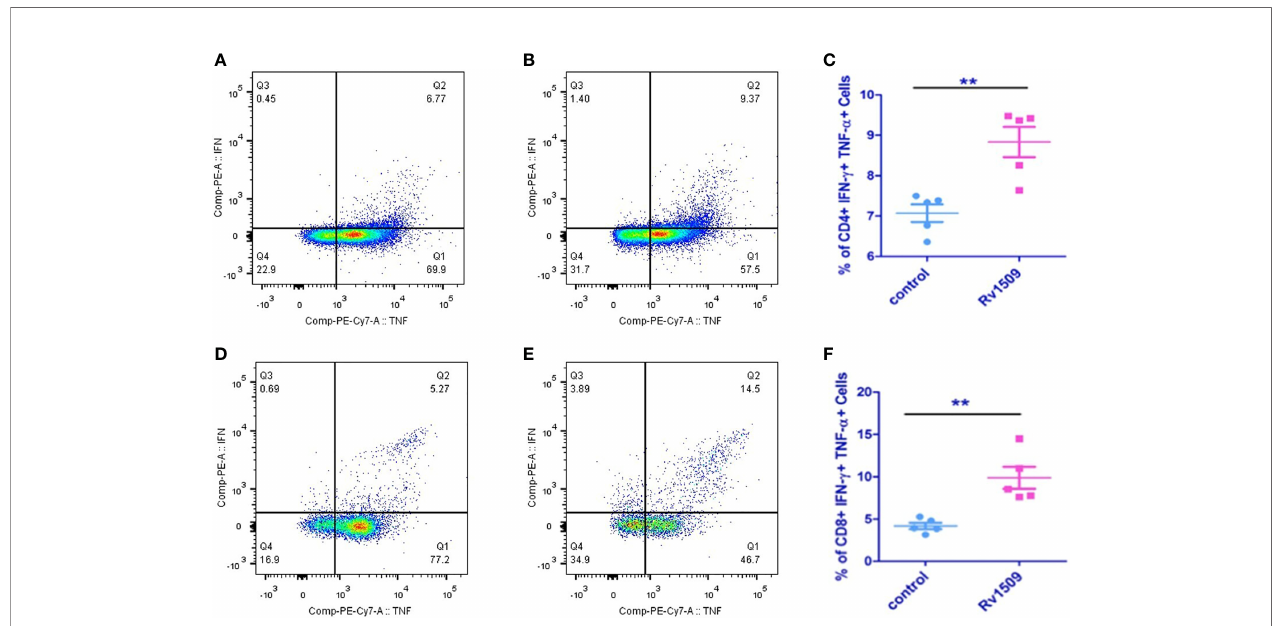
FIGURE 5 | Recombinant Rv1509 protein increases number of poly-functional IFN g and TNF a secreting CD4+ and CD8+ T cells. Splenocytes from immunized and control mice were re-stimulated with polymyxin treated recombinant Rv1509 protein in culture in the presence of Golgi plug/Golgi stop solution for 8 hours. Cells were washed, harvested and labelled for CD4+/CD8+ surface marker and intracellular IFN g and TNF a . FACS analysis was performed by selecting splenocyte population followed by gating for CD3 initially. Selected population was then double gated to reveal CD4+ and CD8+ population. The CD4+ and CD8+ populations were then individually gated for IFN g and TNF a . The Dot plots represent the percentage population of polyfunctional T cells (IFN g +TNF a positive cells) from a single experiment, representative of total of two experiments. (A, B) Representative FACS plot of control and Rv1509 protein treated cells. (C) Rv1509 treatment increases the number of CD4+ cells double positive for IFN g and TNF a . (D – F) FACS plots and graph represent the CD8+ T cells in control and Rv1509 immunized animals after in vitro stimulation with protein. Rv1509 protein treatment results in an increase in number of CD8+ T cells double positive for IFN g and TNF a . $Representative data are from fi ve samples in each group. (The data are expressed as mean ± SD). **p <